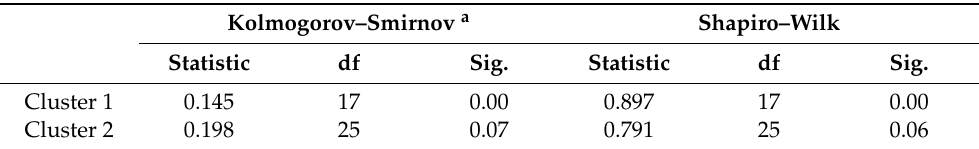
Table 6. Test of normality.